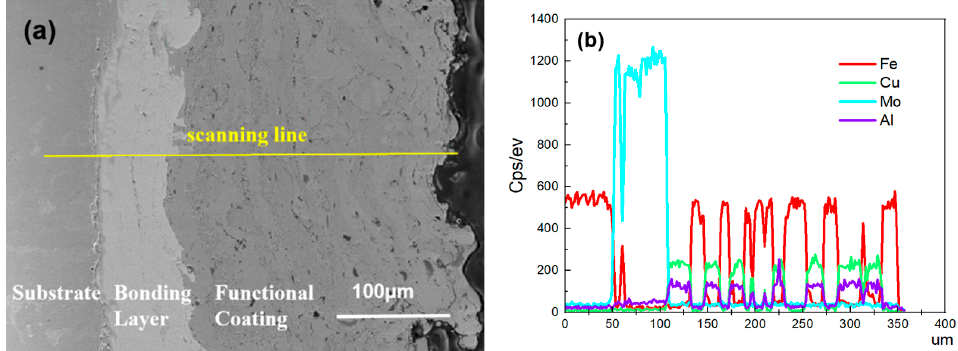
Figure 6. EDS line scan of the cross-section of the composite coating: ( a ) Cross-section; ( b ) Distribution chart of various elements.